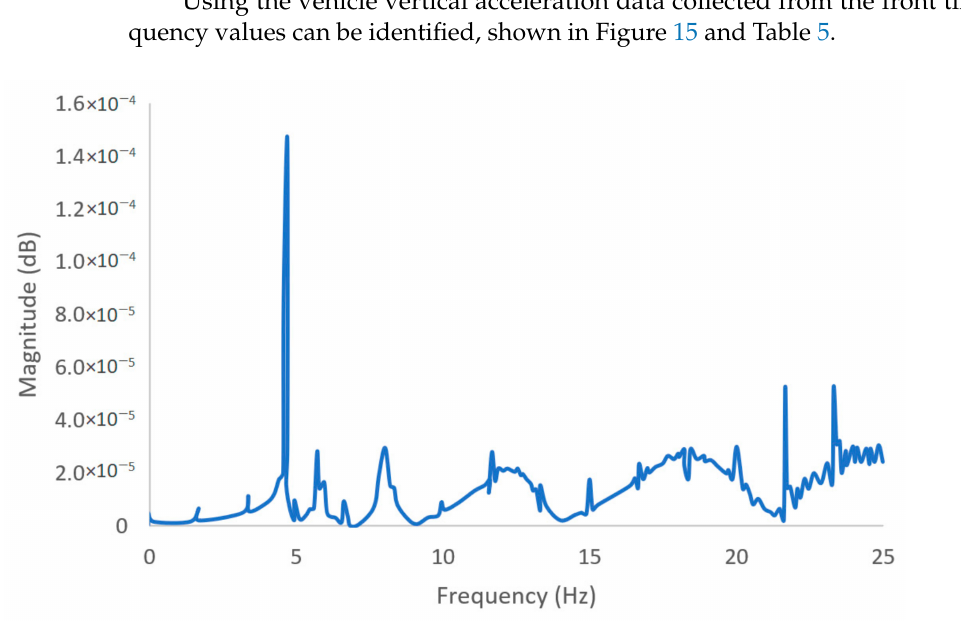
Figure 15. Identified frequencies using the front tire acceleration time